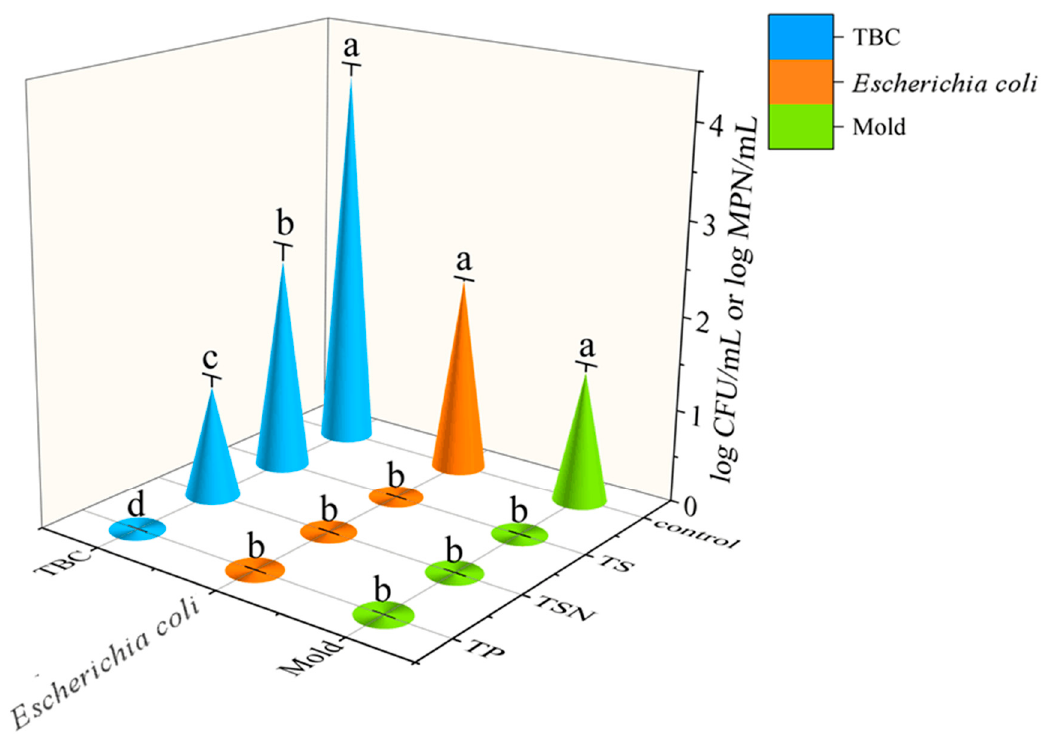
Figure 1. Lethal effects of different sterilization treatments on the microorganisms in orange juice. The Escherichia coli results are expressed as log MPN/mL, and the other results are expressed as log